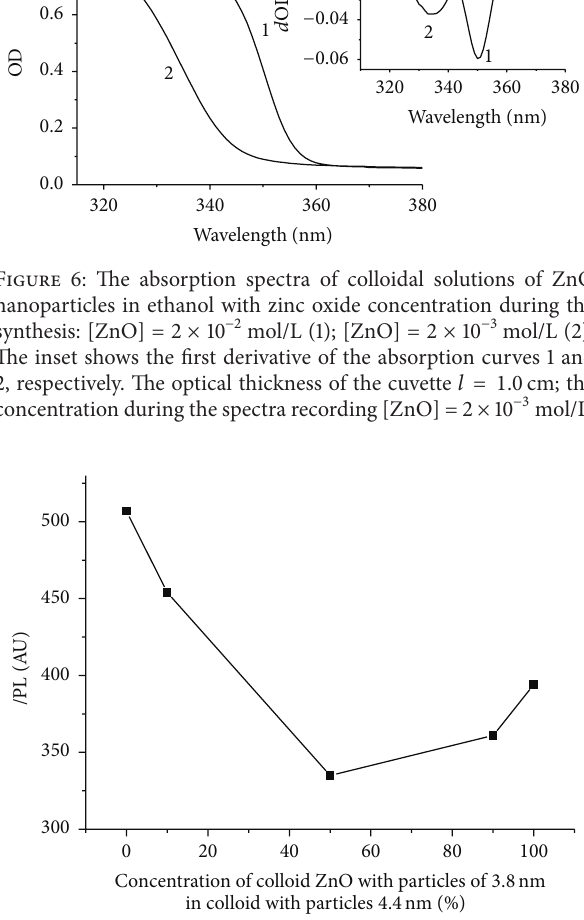
Concentration of colloid ZnO with particles of 3.8 Figure 7: The dependence of the luminescence intensity of the colloid ZnO nanoparticles with size of 4.4 nm on the content of the colloid ZnO particles of 3.8 nm. [ZnO] = 2 × 10 −3 mol/L.